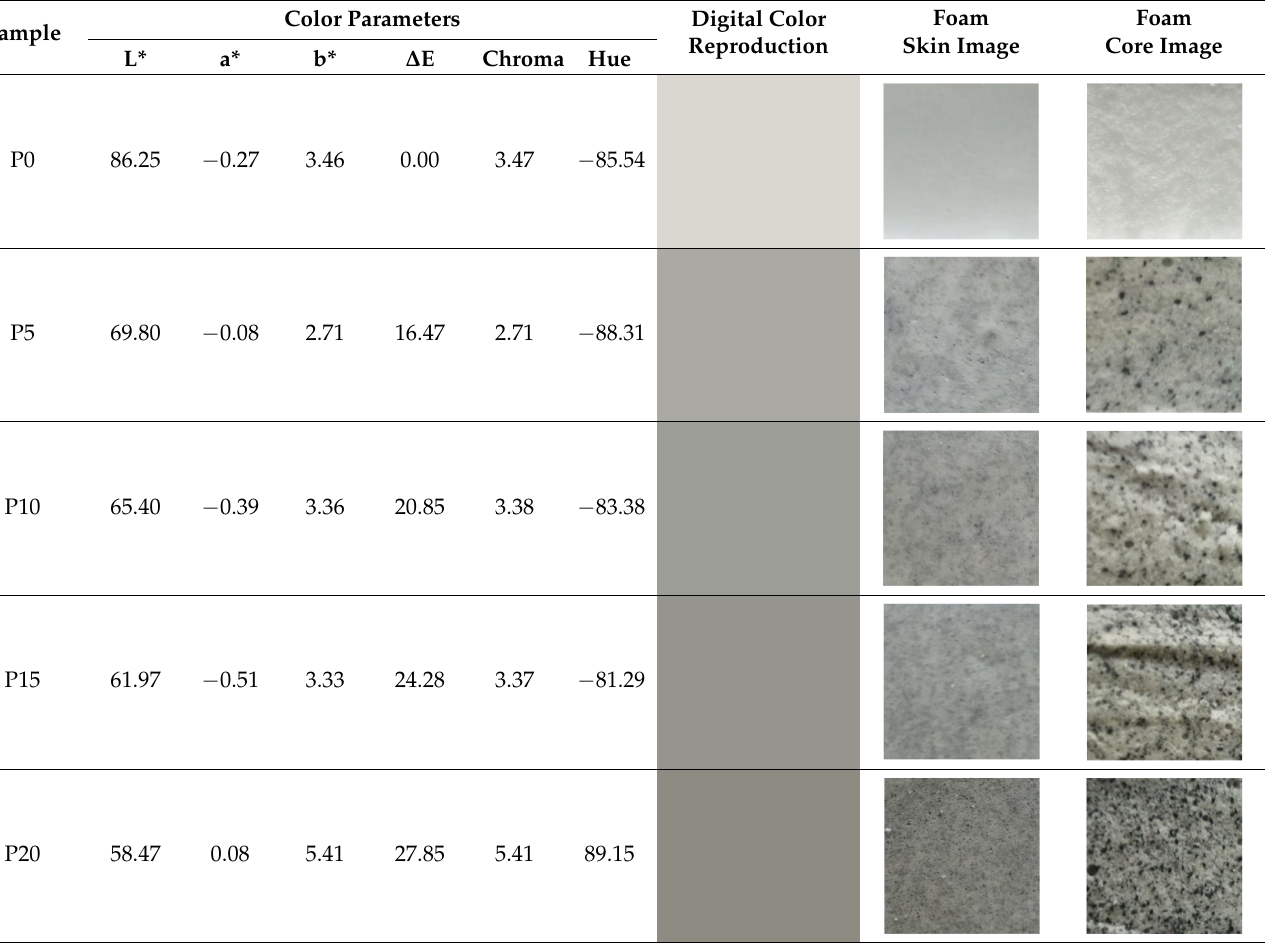
Table 3. Composites’ appearance and parameters describing it in quantitative